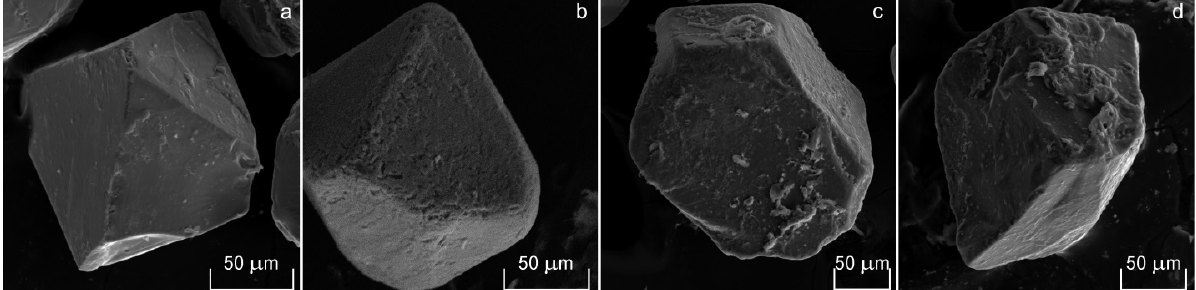
Figure 13. Morphology of chromian spinel grains from the Kiryushkino paleoplacer (SE images): ( a )—non-rounded octahedron (group I), ( b )—octahedron with distorted facets with the shape of a tetragonal trapezohedron (group III), ( c )—distorted flat rhombohedron-shaped grain with pyramidal facets (group IV), ( d )—distorted trigonal trapezohedron-shaped grain (group IV). Chromian spinels from various morphogroups are closely approximated in terms of their average chemical composition (Table 2). This makes the Kiryushkino paleoplacer similar to the Sabantuy and Novomikhaylovka paleoplacers. The bulk of analyses com- plies with the chromite composition, a great number of points on the Al 3+ –Cr 3+ –Fe 3+ dia- gram fall into fields of alumochromite and subferrichromite (Figure 7h). Only one anal- ysis of Ti-low chromite was obtained for group I. In contrast to the other placers, chromian spinels of group VI are the highest in Cr here (Cr 2 O 3 54.3 wt.% on average, Cr# = 0.83), while the ZnO content in them is below the detection limit, which differs from chromian spinels of group VI in the other studied placers. However, all grains are cor- roded. Chromian spinels of group V are the highest in Mg (MgO 12.0 wt.%, Mg# = 0.56), while chromian spinels of group III are the lowest in Mg (MgO 7.9 wt.%, Mg# = 0.39). Chromian spinels of group II are compositionally identical to group II of the Novomi- khaylovka paleoplacer (Cr# = 0.74, Mg# = 0.43). 5. Discussion 5.1. Environment of Sedimentation Metamorphic, sedimentary and magmatic complexes of the collisional orogeny contributed to the formation of the Middle Permian Molasse formation terrigenous de- posits in the Pre-Urals [73]. The presence of ultramafic rocks in the provenance is evi- denced not only by a high chromian spinel content of the sandstone heavy mineral frac- tion, but also by geochemical features of sandy and argillaceous rocks rich in Cr and Ni [73]. Our petrographic studies of the Kazanian sandstones showed that the bulk of clasts could be transferred from decomposed Riphean sedimentary-metamorphic complexes of the Bashkir Meganticlinorium [21]. The Early Permian Ural Foredeep had been filled in by the Early Biarmian (Guadalupian) epoch detrital material that was distributed further westwards simultaneously with the sea regression [69]. The terrigenous material was transported by large rivers oriented sublatitudinally [21,81]. The find of chromite paleo- placers in the Kazanian sediments clearly indicates an episodic exhumation in the prov- enance of chromite-bearing complexes potentially rich in chromite. The structural and textural features of the studied sandstones indicate their sedi- mentation in the aquatic settings. The presence of sandy gravel sediments on the one hand and limestones on the other (Figure 3) in thin sections, as well as finds of brachio- pods and vegetal detrital material (even large tree trunks in the Bazilevo section) suggest recurring fast interchanges of continental settings and shallow-marine and vice versa. The lithology of chromite-bearing sections is similar, but there is no identical section, which witnesses local differences of the sedimentation environment. Most of the studied placers (excluding the Sabantuy) show either unidirectional cross-bedding of chro- mite-rich sediments or subhorizontal bedding in thin rapidly pinching out lenses of sandstones. Sandy lenses are commonly wavy in the longitudinal section. Their grains